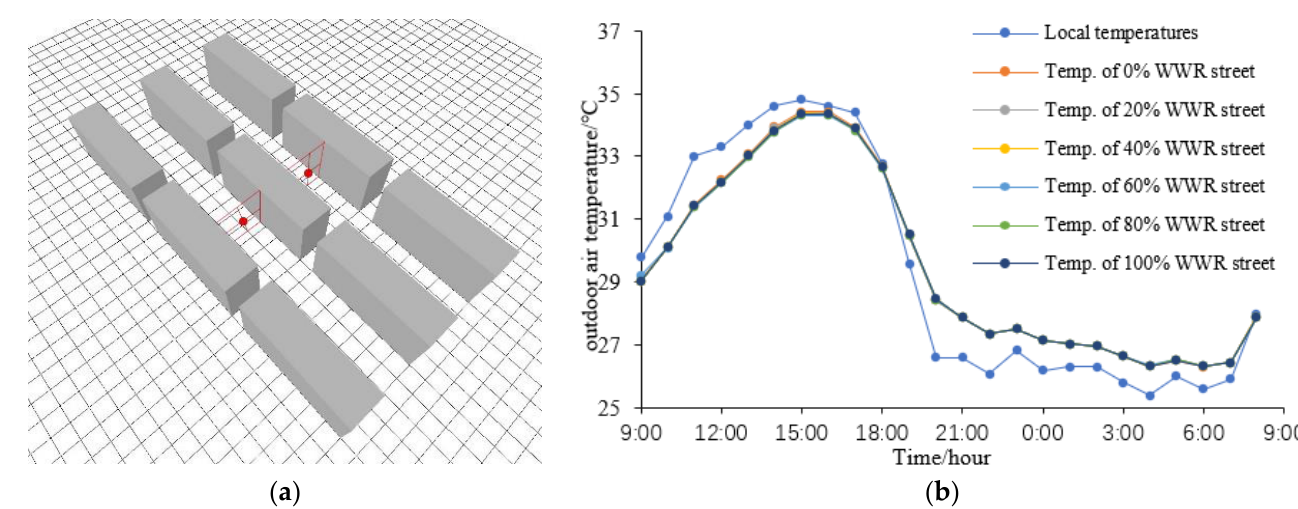
Figure 11. ( a ) Temperature collected points; ( b ) The mean outdoor